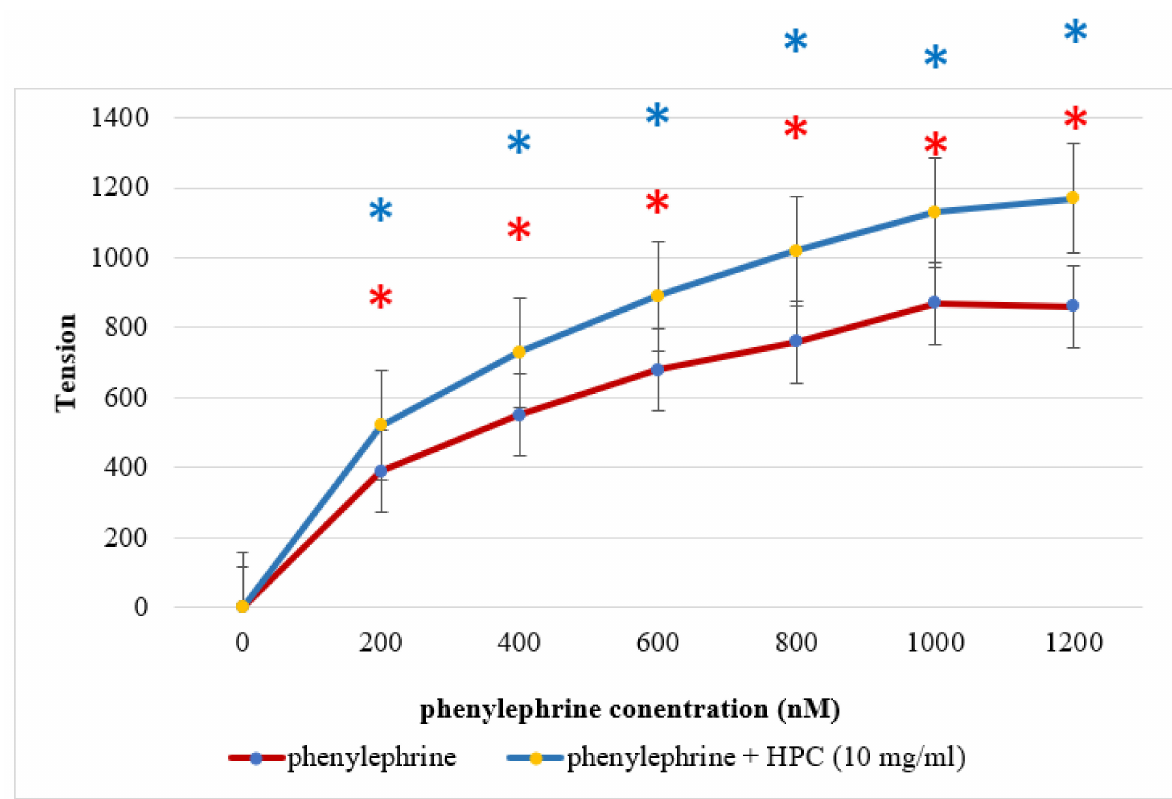
Figure 5. Vasocontraction effects of anti-hemorrhoidal polyherbal cream (HPC). Blood vessels were harvested from Sprague–Dawley male rats and treated with10 mg HPC/mL. Values represent means ± SD of six independent experiments carried out in triplicates. * p < 0.01—significant as compared with